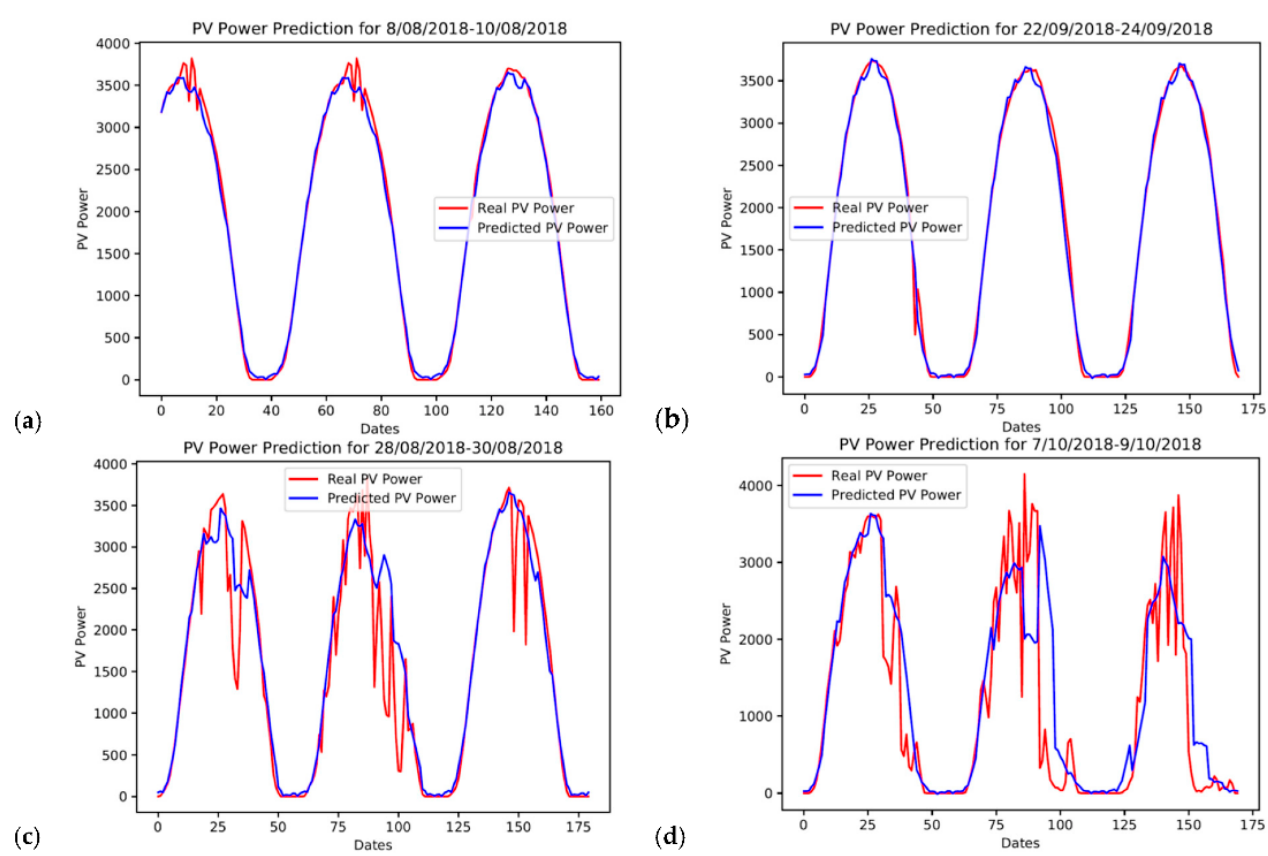
Figure 3. Actual PV power output signal (red line) and predicted PV power output signal (blue line) for some selected days of the test set ( a ) 8 August 2018–10 August 2018, ( b ) 22 September 2018–24 September 2018, ( c ) 28 August 2018–30 August 2018, ( d ) 7 October 2018–9 October 2018 (Reprinted from Ref. [9]).